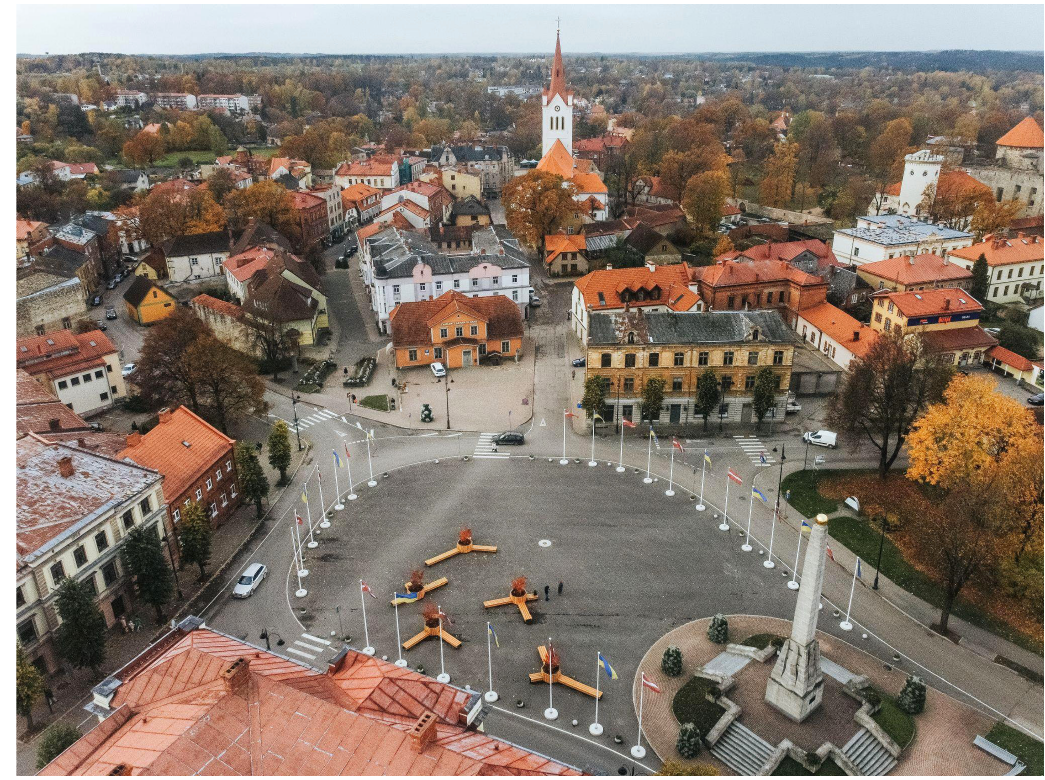
Figure 8. Vienības Square in 2022 with mobile furniture and Cēsis Old Town in the background.